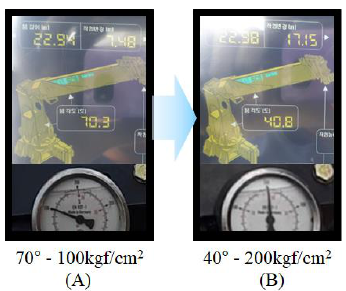
Figure 16. Experiment outputs: boom angle and derrick cylinder pressure.